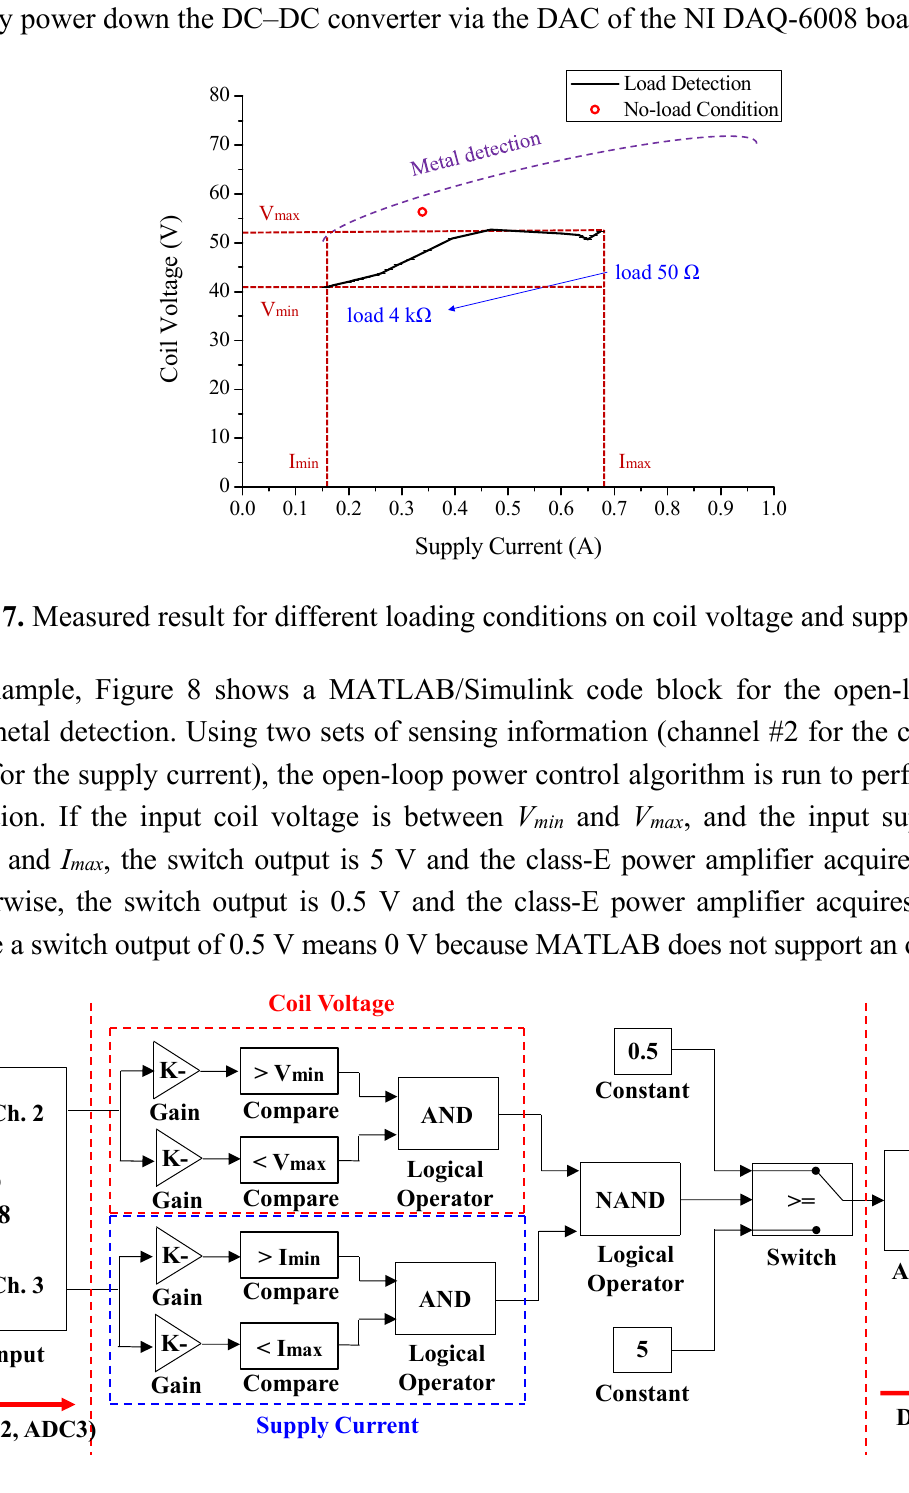
Figure 8. MATLAB/Simulink code for ON/OFF control